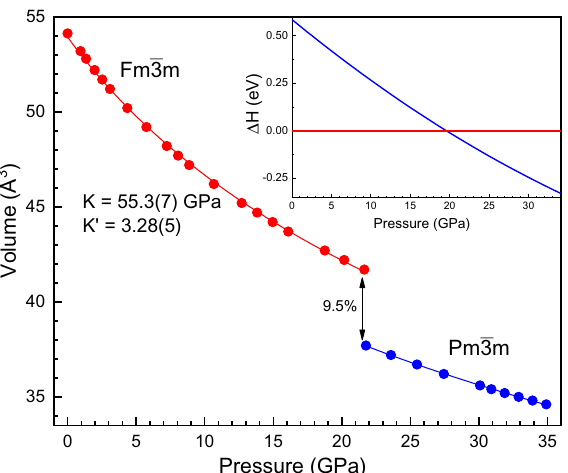
Figure 1. Volume-pressure curve up to 35 GPa showing the volume collapse of 9.5% at the B1–B2 phase transition at 21.5 GPa. The enthalpy-pressure curves are represented in the